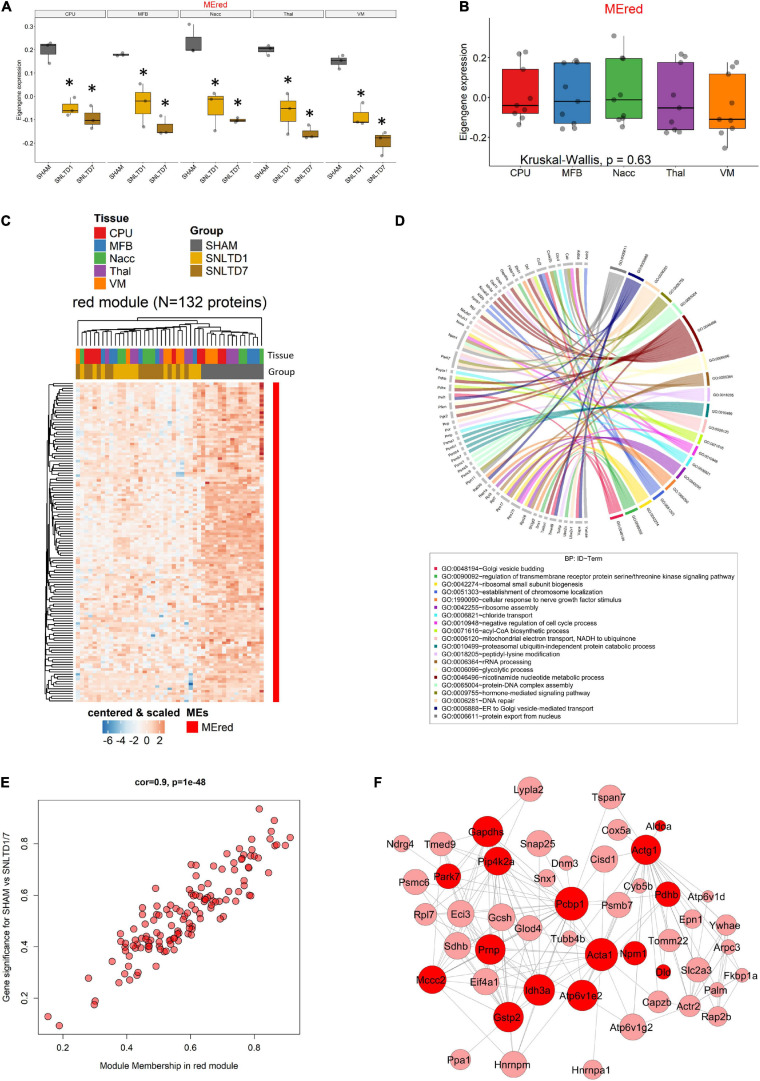
Analysis of the red module. (A) Boxplot showing the expression of the red module’s ME (MEred) across sham, day 1, and day 7 conditions for each tissue. *Corresponds to statistical significance compared to Sham. (B) Boxplot illustrating the expression of MEred across tissues. Kruskal–Wallis test was used for multiple comparisons. (C) Heatmap showing the expression profile of the 132 proteins forming the red module. (D) Circos plot displaying GO biological process (BP) terms that are significant enriched in red module proteins. (E) Module membership (MM) was defined as the correlation between gene expression and module eigengene. Gene significance (GS) was defined as the correlation between gene expression and SHAM compared to the combined days 1 and 7 conditions, regardless of regions. (F) Protein–protein interaction network of hub genes in the red module. Node size and edge width are, respectively, proportional to module membership (MM) and weighted correlation. Only genes with weighted correlation greater than 0.08 are shown. Proteins related to metabolic processes are highlighted in bright red color.